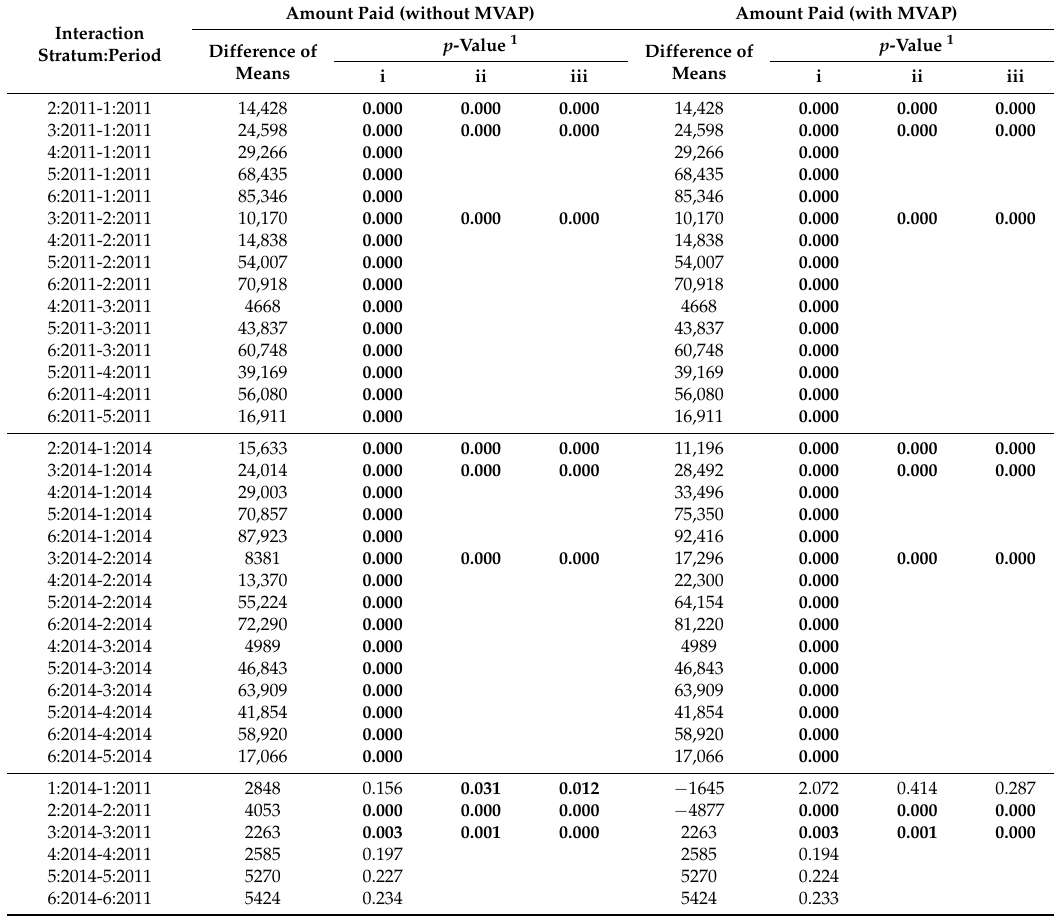
Table A7. Tukey’s Test. Variables: Amount Paid without the programme discount and considering the programme discount for water and sewerage services.